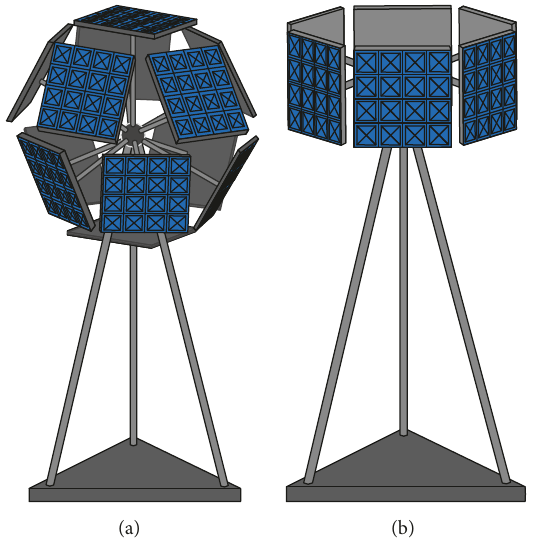
Figure 1: Antenna array structures: (a) polyhedron-based array and (b) hexagonal 6-sector